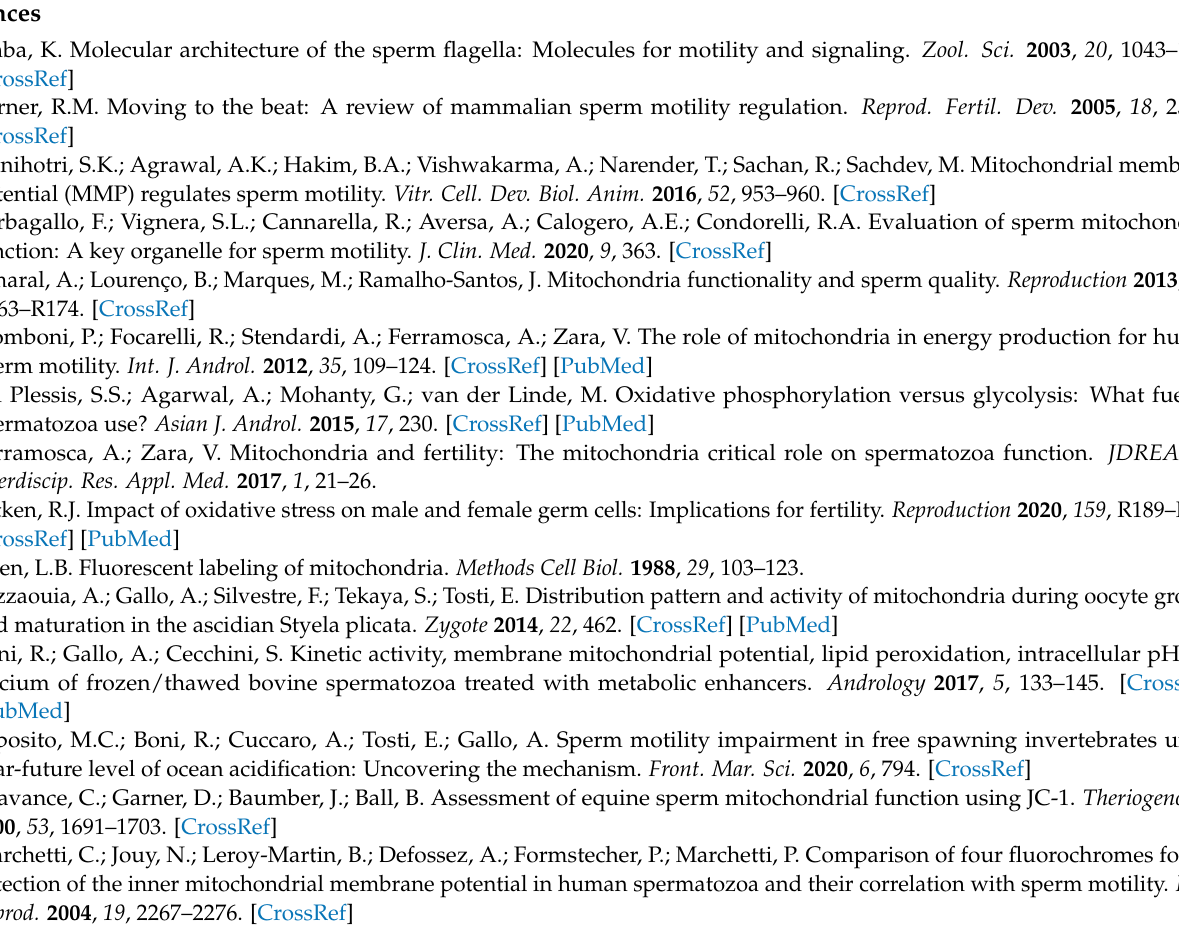
Figure S3: Correlation plots between Total motility (Tot Mot), mitochondrial membrane